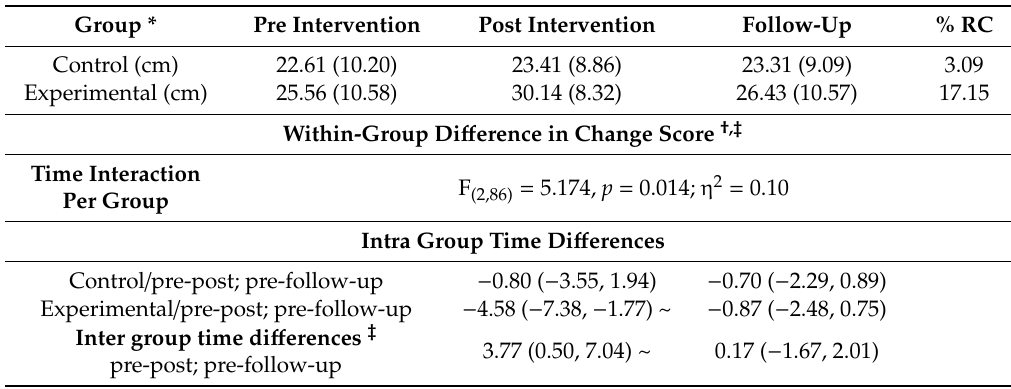
Table 2. Jump height intra- and inter-group di ff erences.